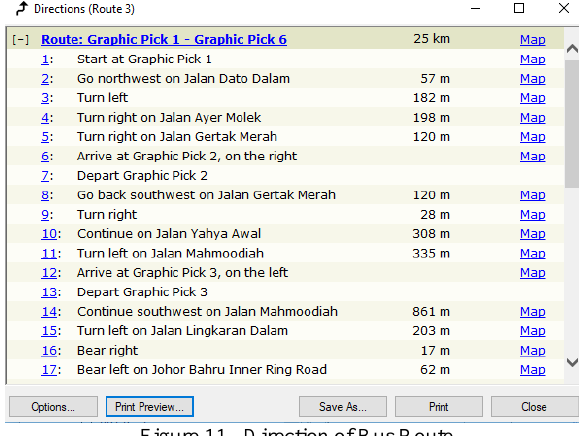
Figure 11 Direction of Bus